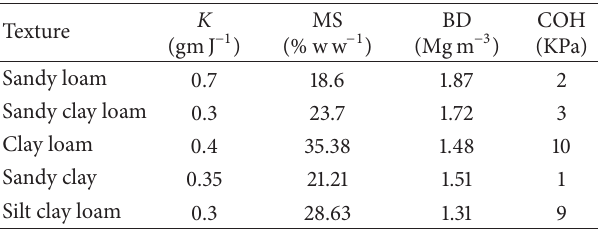
Table 2: Soil related hydrological parameters values for soil texture in the Mai-Negus catchment.